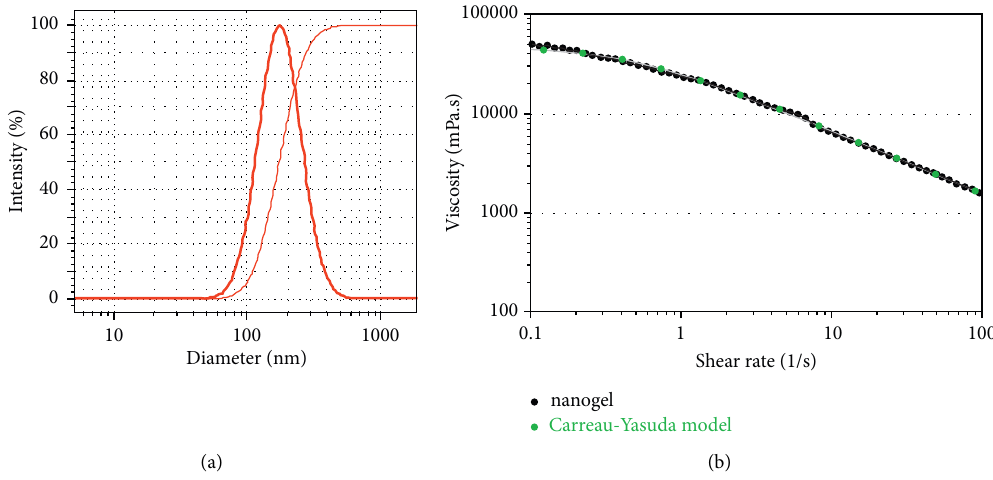
Figure 1: (a) DLS analysis of EGEO-nanoemulsions with a droplet size of 176 ± 8nm and (b) viscosity of the EGEO-nanogel.